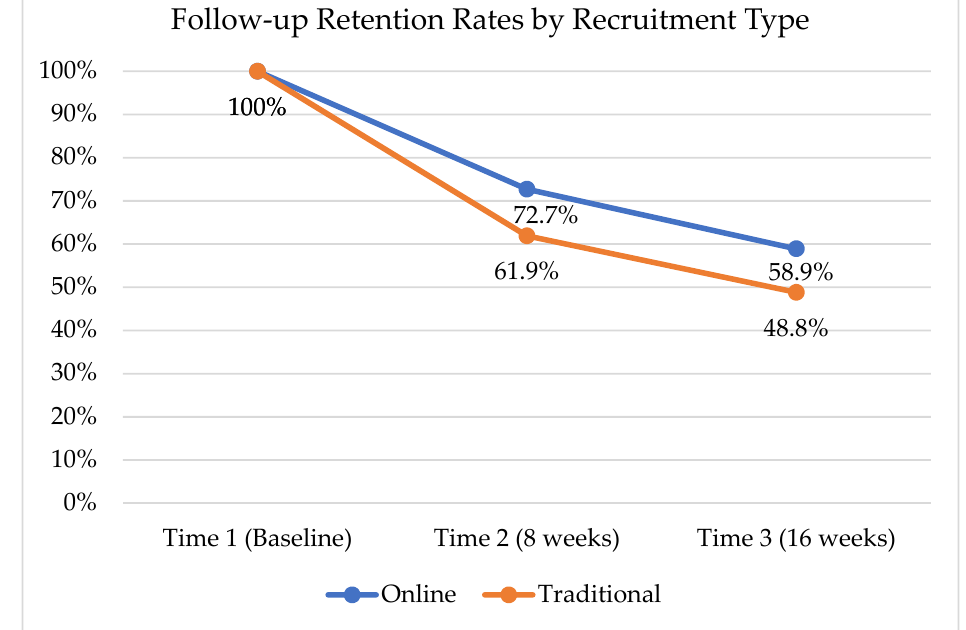
Figure 1. Overall retention by recruitment type.